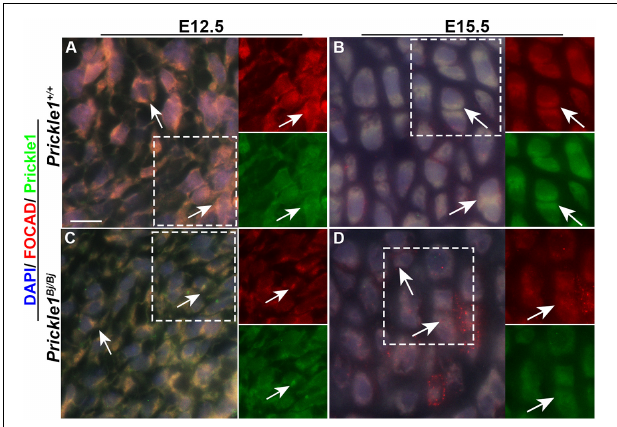
FIGURE 7 | Prickle1 and Focadhesin proteins co-localize in the mouse cranial base mesenchyme. Dual immunofluorescence images of Prickle1 ( green ) and Focadhesin ( red ) proteins, with the nuclei stained with DAPI ( blue ). The areas within the white boxes are presented as single channels beside the combined image. (A,C) Embryonic day 12.5 cranial bases: in the Prickle1 + / + mesenchyme, the Prickle1 and Focadhesin proteins are co-localized ( yellow , arrows ), while in the Prickle1 Bj / Bj mesenchyme, the signals are co-localized in bright foci, but in the cell periphery. (B,D) In Prickle1 + / + chondrocytes, the signals co-localize ( yellow , arrows ) at the cleavage furrow. In Prickle1 Bj / Bj chondrocytes, Focadhesin is found in numerous puncta and in some cleavage